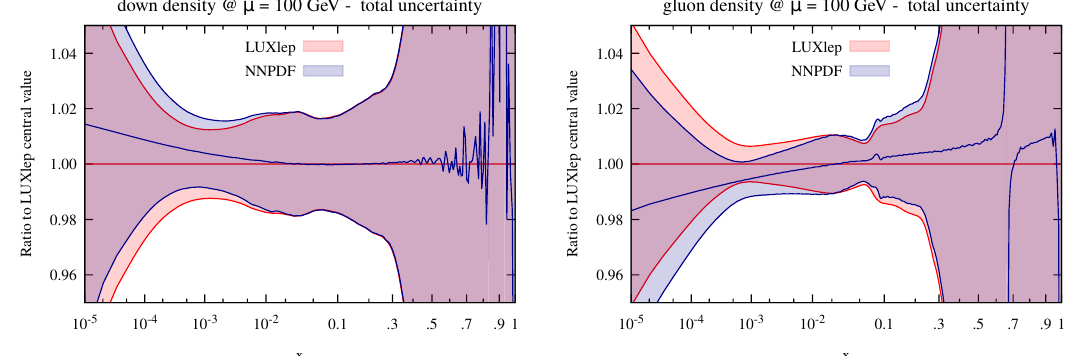
Figure 4. The full uncertainty band of the quark down (left) and gluon (right) densities in the LUXlep and in the NNPDF sets, normalized to the central value of LUXlep . The uncertainty band is obtained with the standard procedure that is adopted with replicas.